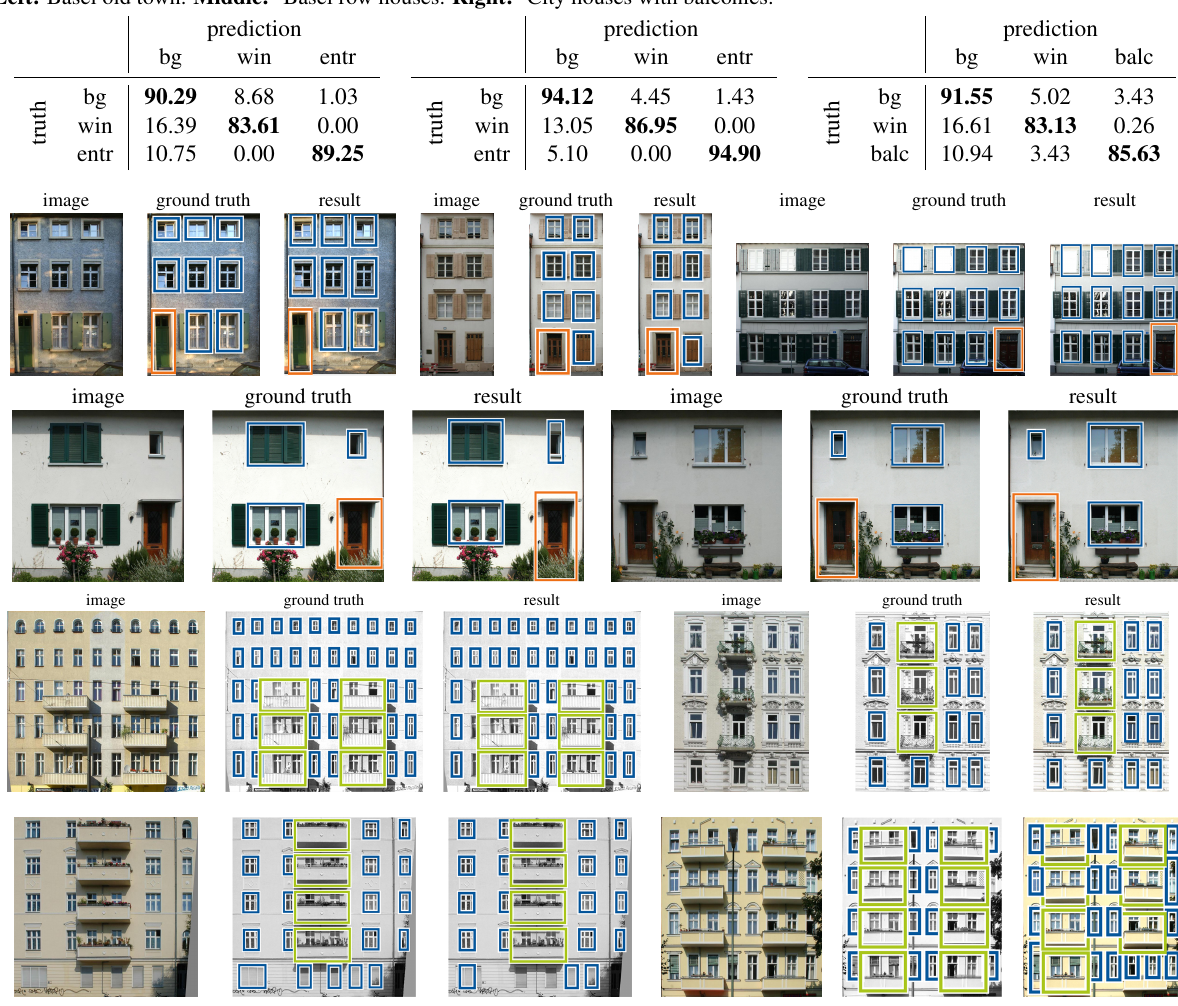
Figure 4: Sample results. 1st row: Basel old town dataset, using weights λ 1 = λ 2 = 0 . 3 . 2nd row: Basel row houses dataset, using weights λ 1 = λ 2 = 0 . 4 . 3nd and 4th row: city houses with balconies, using weights λ 1 = λ 2 = 1 / 5 . Colours as given in Fig.